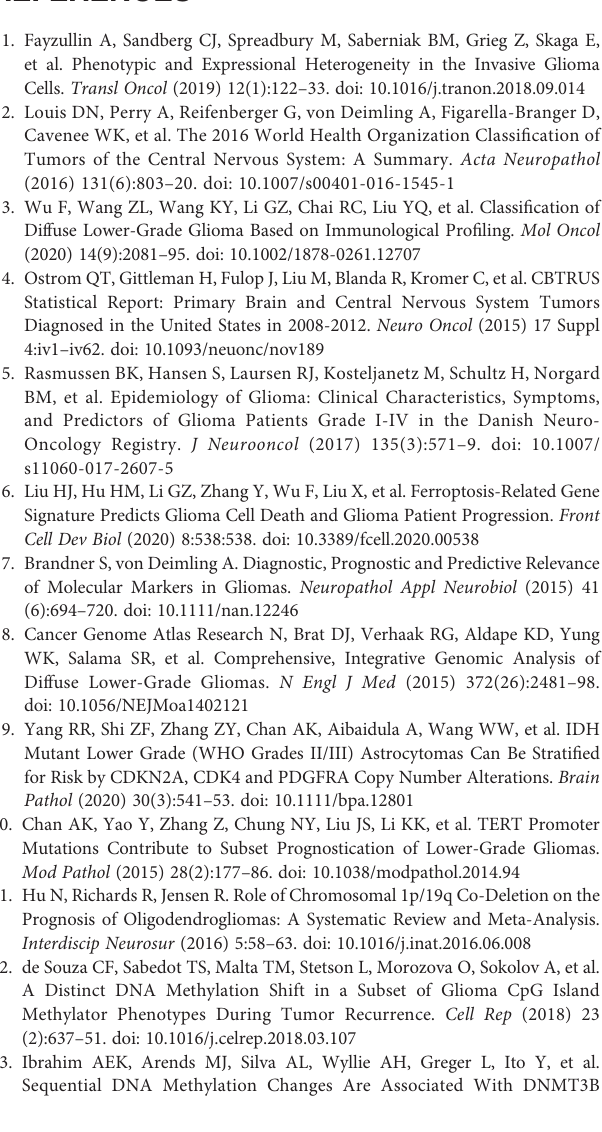
Supplementary Figure 11 | Statistical test the suitability of age and transcriptional risk score. (A) , the HR of transcriptional risk score showed an inverted U-shaped distribution along with the increase of age. (B, C) , the Martingale residuals demonstrated the linear relationship between age and transcriptional risk score with the logit transformation value of the hazard. (D, E) , the RCS analysis veri fi ed the linear relationship between age and transcriptional risk score with the logit transformation value of the hazard. Supplementary Figure 12 | Assessment the differential distribution of mRNA expression levelofthe risk geneclusterin LGGpatients usingCGGAdataset. (A-F) , the differential distribution of risk gene cluster mRNA expression level in IDH wt / 1p19q non-codel and IDH mut /1p19q codel in CGGA cohort (all *** P <0.001, with t test). Supplementary Figure 13 | The survival plot of the risk gene cluster in LGG patients in CGGA dataset. (A-G) , the Kaplan-Meier survival analysis of DDIT4L